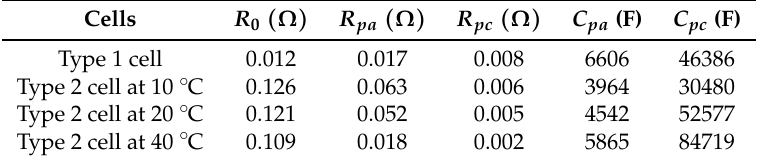
Table 3. The identification results of parameters R 0 , R pa , R pc , C pa and C pc for two types of cells. Cells R 0 ( Ω ) R pa ( Ω ) R pc ( Ω